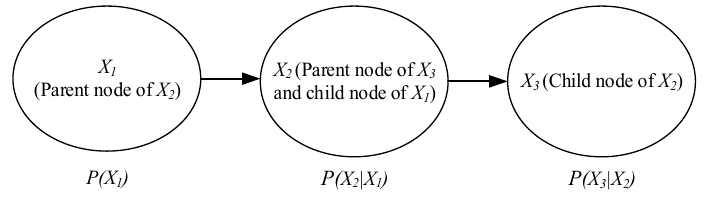
Figure 1. A simple Bayesian belief network.